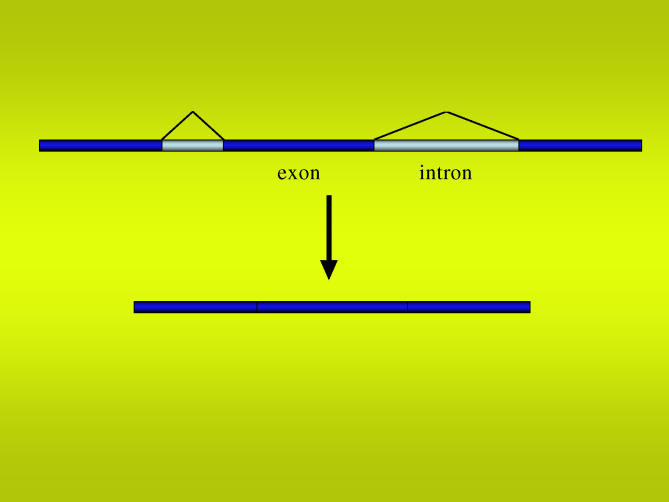
Before a transcribed gene is translated into the amino acids of its encoded protein, noncoding intron sequences are removed and the remaining coding exons are spliced together.